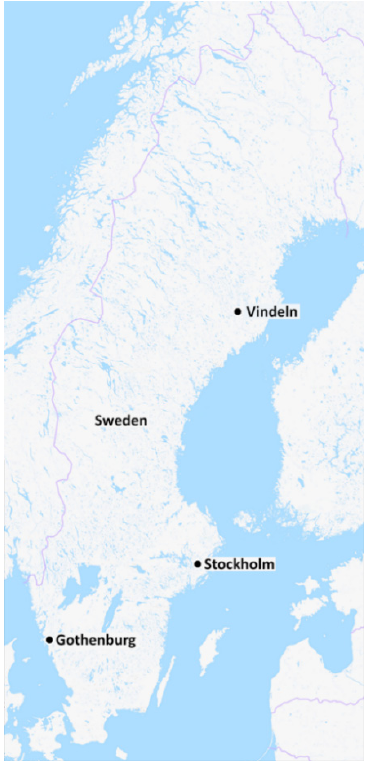
Figure 4. The locations and cities investigated in this case study. Table 1. The windows and construction elements related to the as-built design of the high-rise apart- ment building, as well as the design variables related to the passive energy efficiency measures that were subjected to optimization (i.e., components and materials that are highlighted in bold italics).